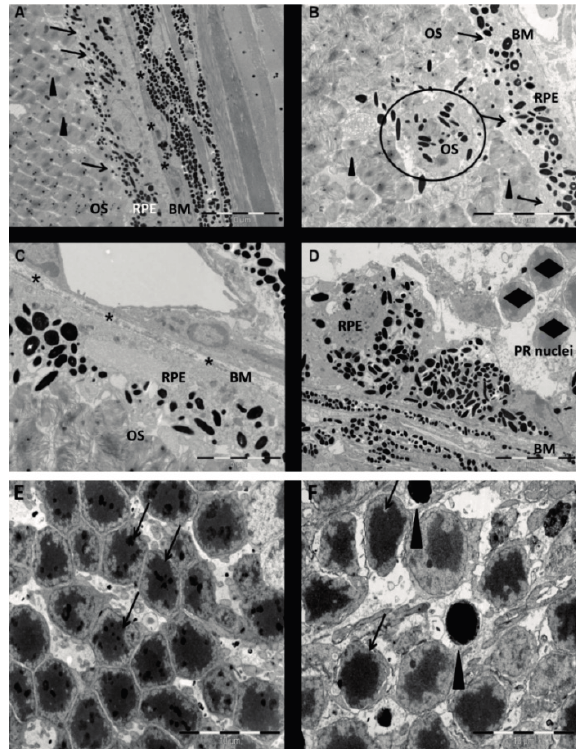
Figure 1. Time-dependent alterations in the outer retinal structure of mice induced by the retina toxin sodium iodate (NaIO 3 ). ( A ) Under physiological conditions, retinal pigment epithelial (RPE) cells display apically located melanin granules and microvilli (arrows) engulfing photoreceptor outer segments (arrowheads). Normal Bruch’s membrane is marked by asterisks; ( B ) Three days post-injection of 35 mg/kg NaIO 3 , microvilli were not present on the RPE surface (arrows) and RPE cells as well as melanin granules (black circle) are displaced into the layer of the outer segments (arrowheads); ( C ) The RPE monolayer was disturbed and the Bruch’s membrane appeared swollen (asterisks); ( D ) The epithelial monolayer was completely disrupted and individual RPE cells showed a rounded phenotype two weeks after injection. The remaining photoreceptors (PRC) nuclei (diamonds)